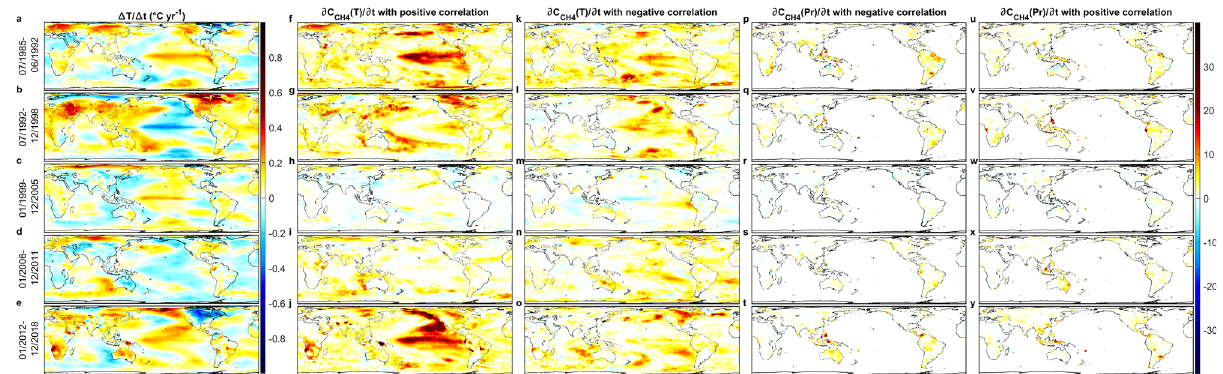
Fig. 4 Observed spatial distribution of temperature changes and estimated c- contributions to dC CH4 /dt over different time periods. a – e Observed